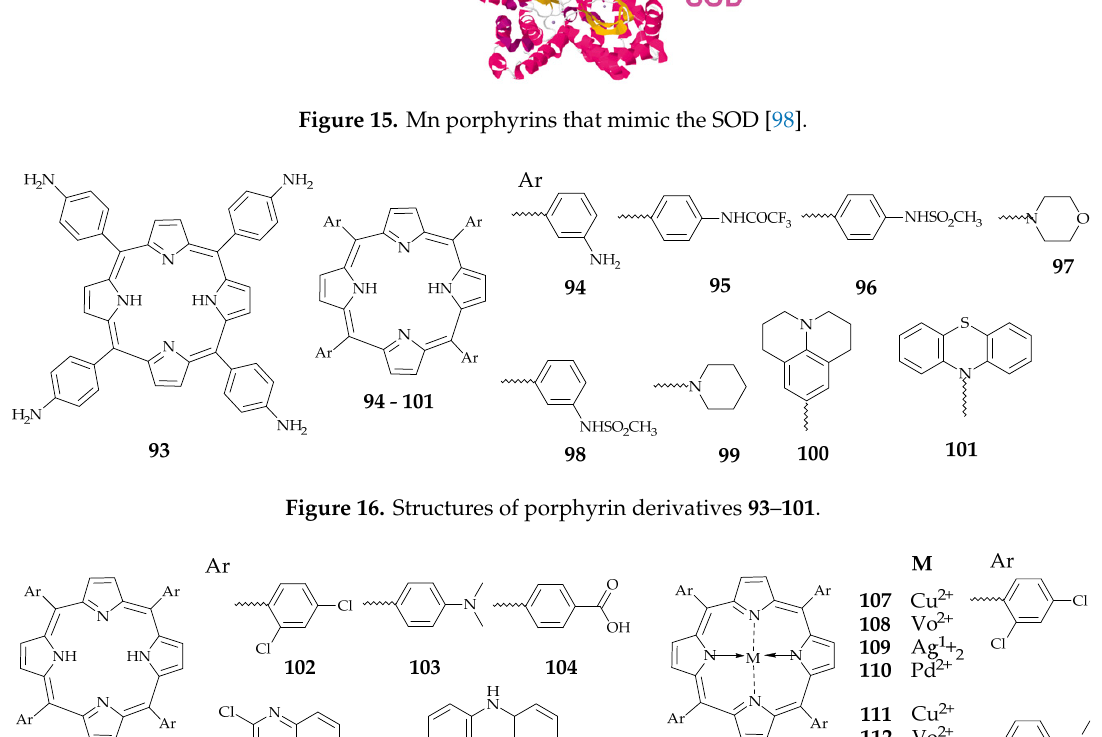
Figure 15. Mn porphyrins that mimic the SOD [98].